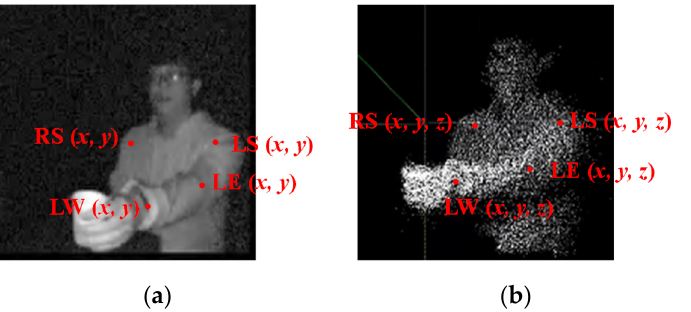
Figure 2. Concepts for: ( a ) 2D images ( M A ), which comprise gray-scale images, and ( b ) 3D images ( M P ), which consist of a point cloud. The features for the human joints in the 2D images ( 𝐽 (cid:2870)(cid:3005) ) can be expressed as: